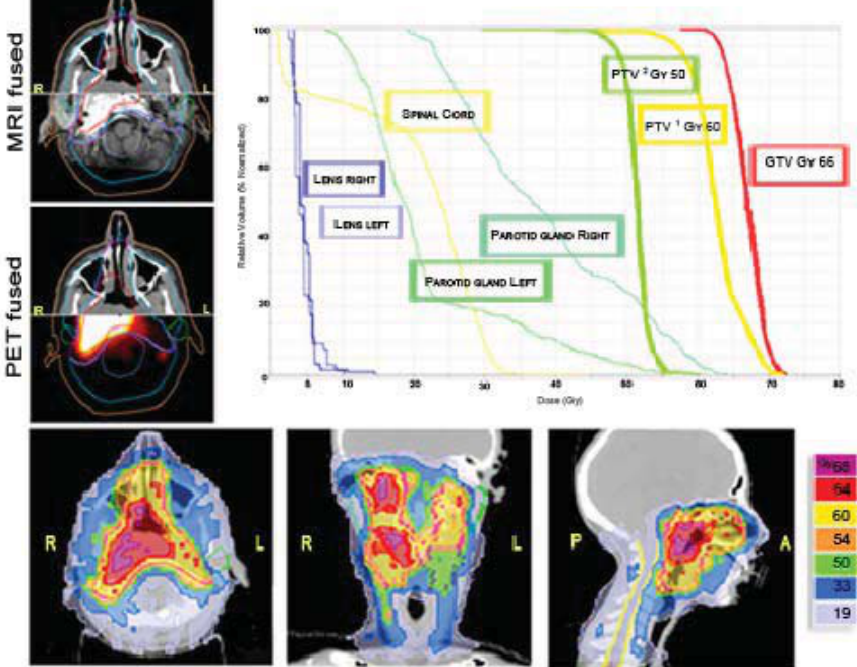
simultaneous integrated boost (SIB) was delivered. 66Gy/30 fractions to the GTV, 60Gy/30 fractions to the PTV1 (high risk CTV + 5 mm margin), 50Gy/30 fractions to the PTV2 (low risk CTV + 5 mm